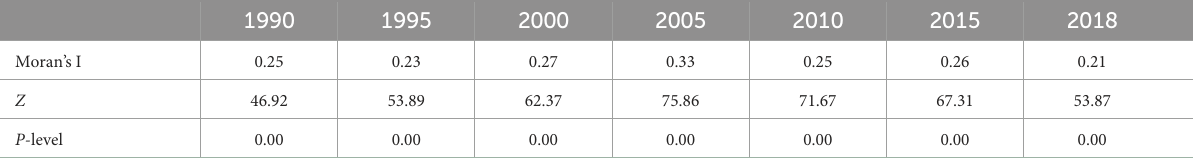
TABLE 5 Spatial autocorrelation indices of the HDI in the Huaihe River